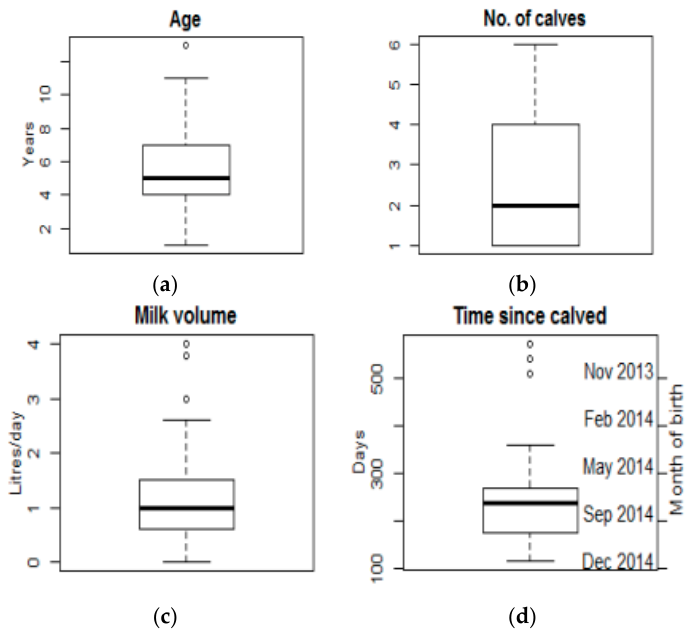
Figure 3. Characteristics of milking cows sampled ( n = 86), including cow age ( a ); number of calves